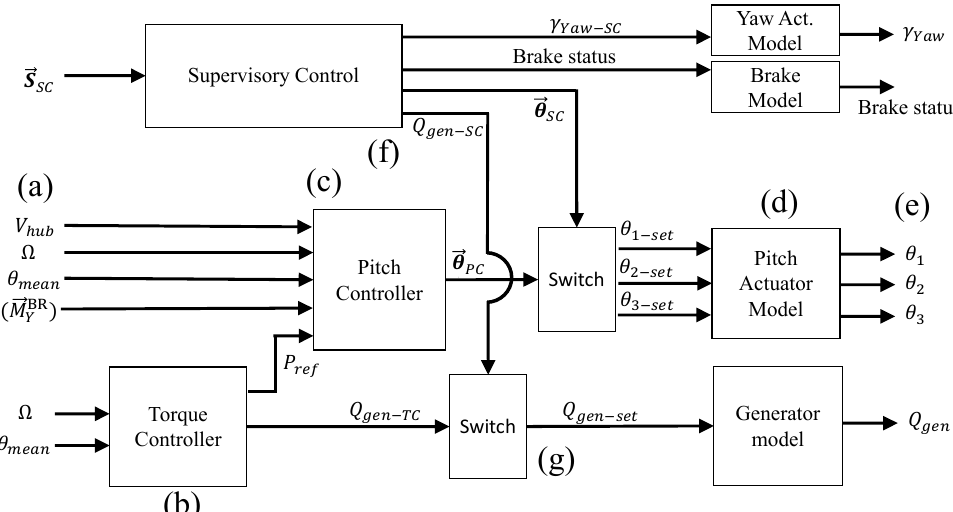
Figure 2. Overview of the controller object. It is comprised of three major modules: the pitch controller, the torque controller and the supervisory control. The latter is able to override the former two with the use of switches. The setpoint signals are passed to the respective actuator model to calculate the actuation